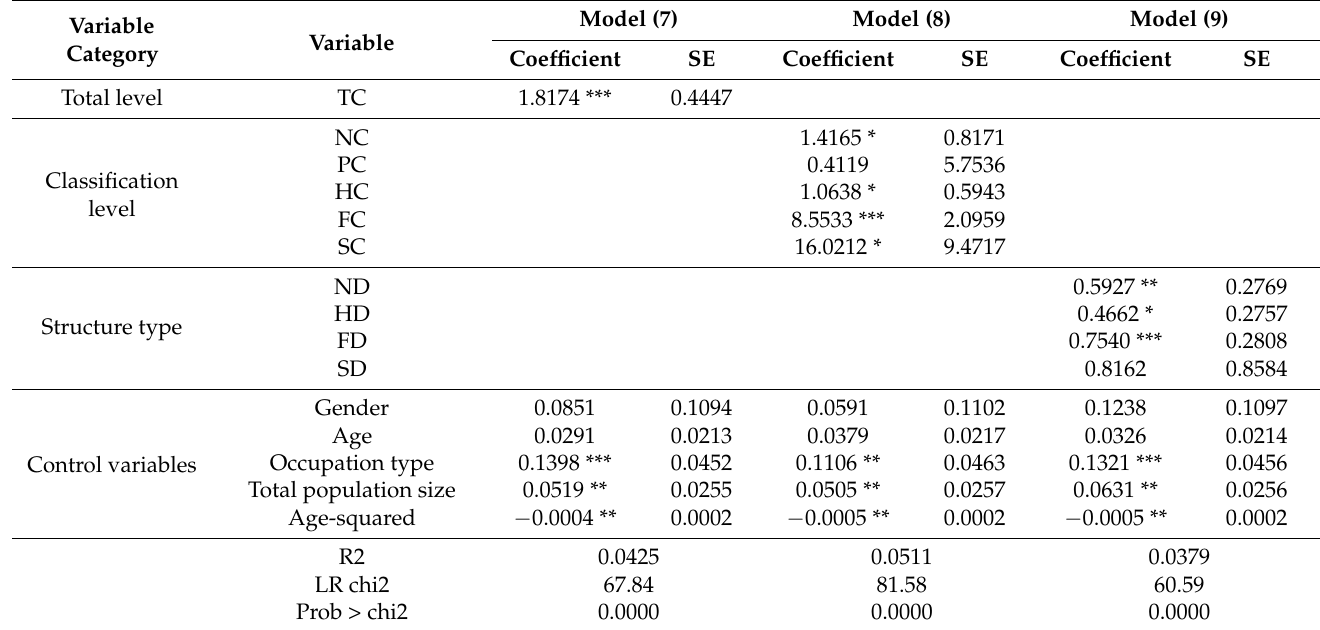
Table 8. Robustness test